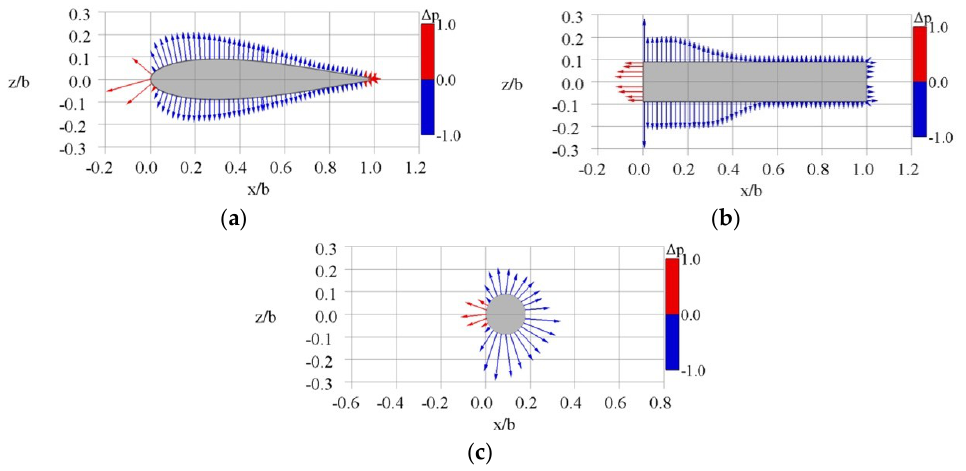
Figure 12. Surface pressure distributions on the arm cross-section of n = 30 in each rotor case with different cross-section arms: ( a ) airfoil arm rotor, ( b ) rectangular arm rotor, and ( c ) circular arm rotor. The values of the color bars showing the surface pressure ∆ p have an arbitrary unit only expressing the direction of the surface